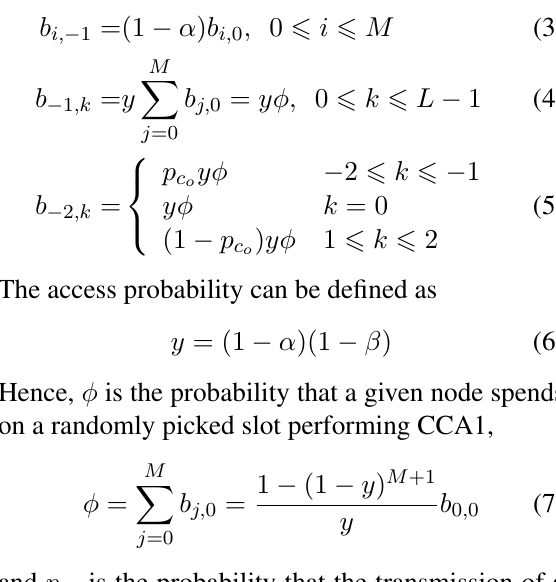
Table 1. For example, when s ( t ) ∈ [0 , M ] , and c ( t ) = − 1 , the state of the node is in CCA2.